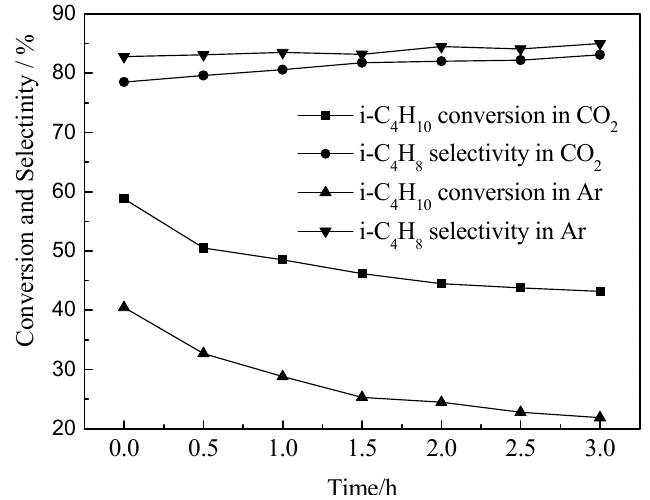
Figure 5. Catalytic stability in dehydrogenation of isobutane to isobutene with CO 2 or Ar over VO x /MSU-1. Reaction conditions: reaction temperature 873 K, total flow rate 24 mL/min, 12 wt. % VO x /MSU-1 0.2 g, V(CO 2 ):V( i -C 4 H 10 ) = 3:1 or V(Ar):V( i -C 4 H 10 ) = 3:1.